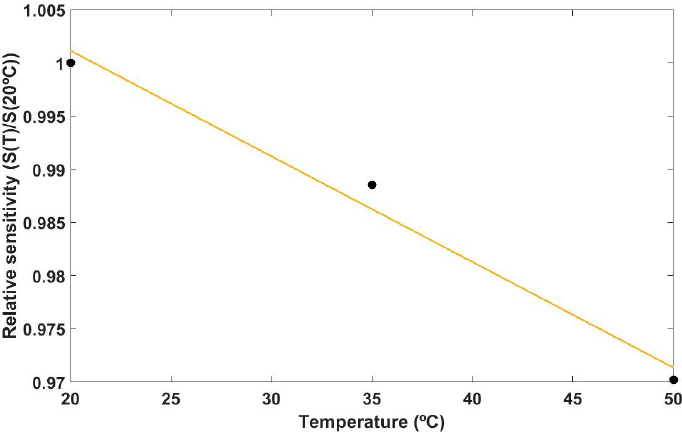
Figure 10. Relative sensitivity as a function of the temperature.